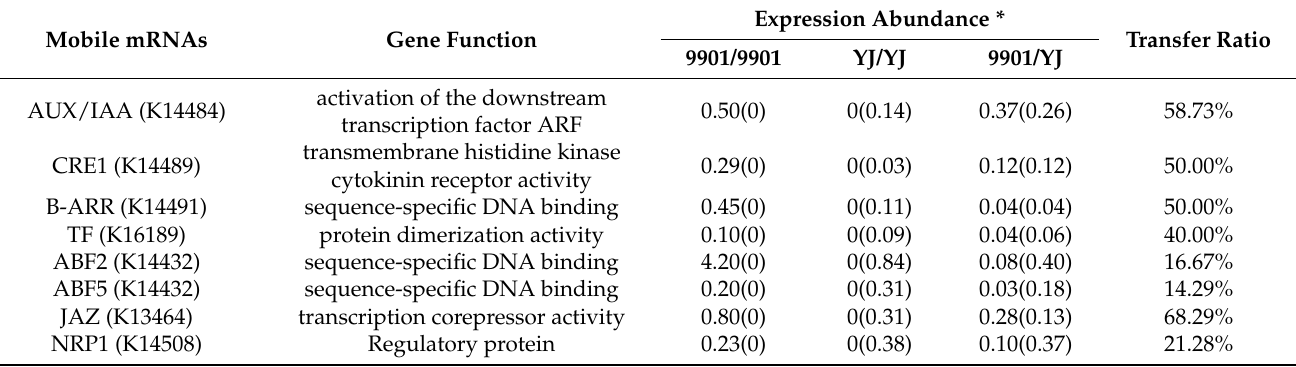
Table 5. The mobile mRNAs involved in the plant hormone signal transduction pathway.